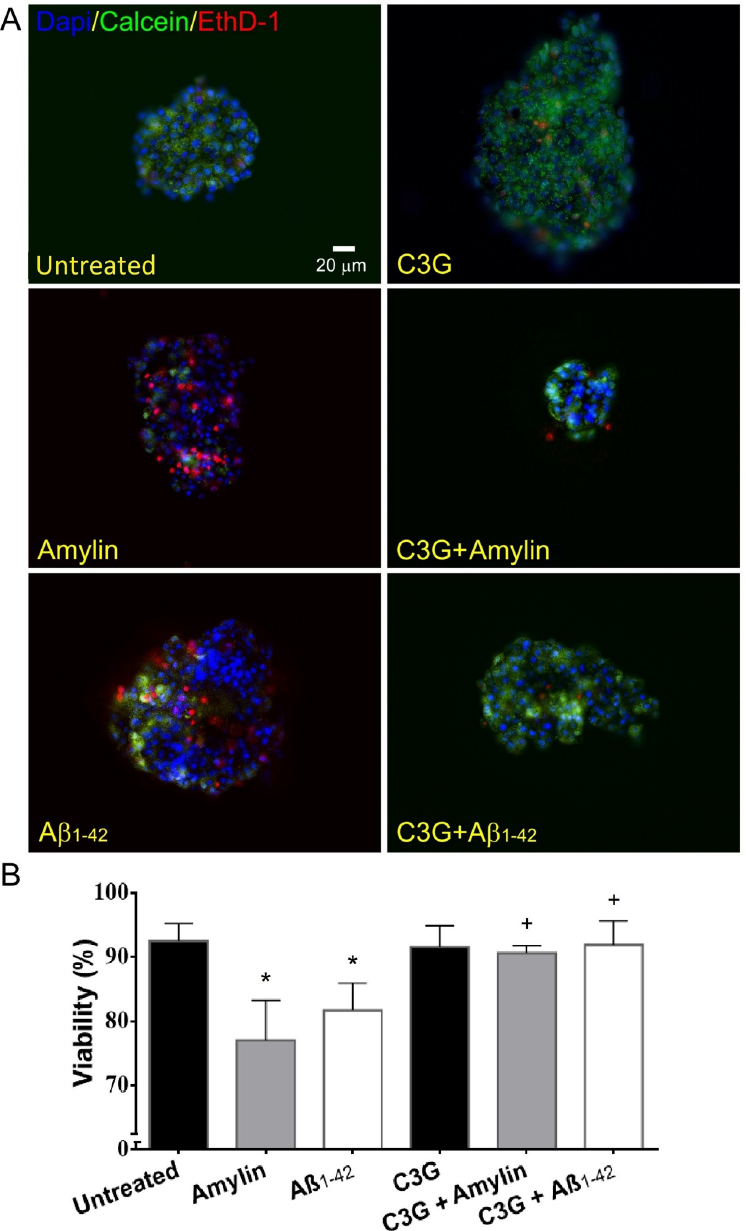
Fig 2. Viability of human islets treated with or without C3G and with or without amylin or A β 1-42 . (A) Islets stained with calcein (green, live), ethidium (red, dead), and DAPI (blue, nuclei). Representative untreated, amylin- treated, A β 1-42 -treated, C3G-treated, C3G + amylin-treated, C3G + A β 1-42 -treated islets are shown. Scale bar represents 20 μ m. (B) Percentage of viability in untreated or C3G-treated islets exposed to amylin or A β 1-42 ( � p < 0.001, untreated vs. amylin; � p < 0.01, untreated vs. A β 1-42 ; n = 4–5; + p < 0.05, amylin vs. C3G + amylin; + p < 0.05, A β 1-42 vs. C3G + A β 1-42 ; n =